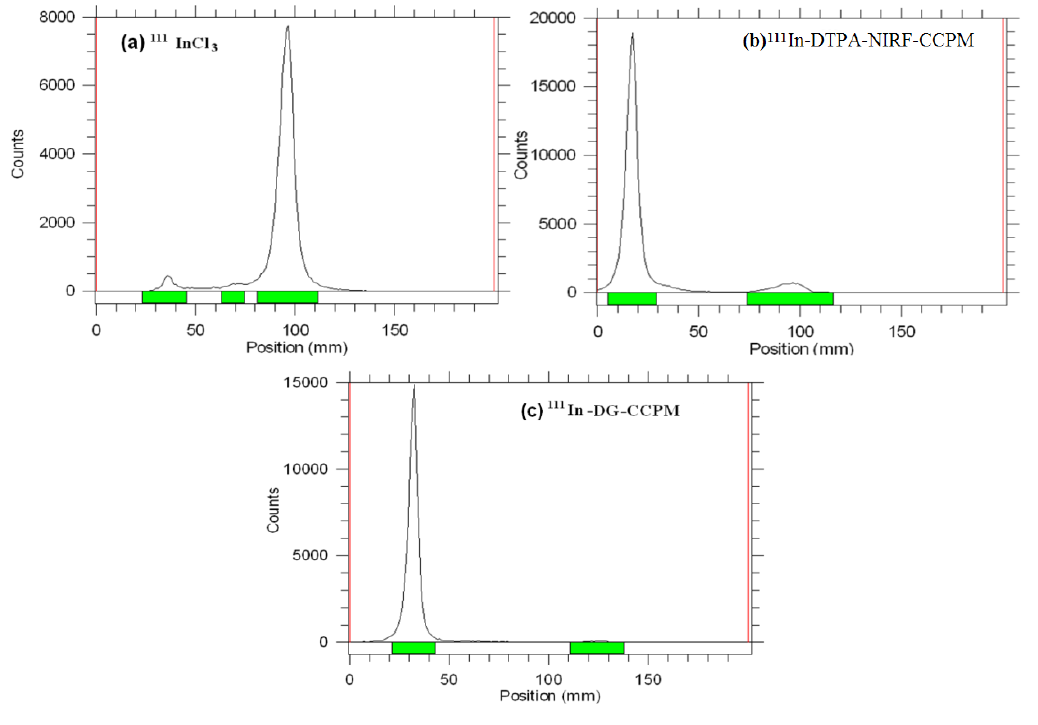
. ( b ) 111 In-DTPA-NIRF-CCPM. ( c ) 111 3